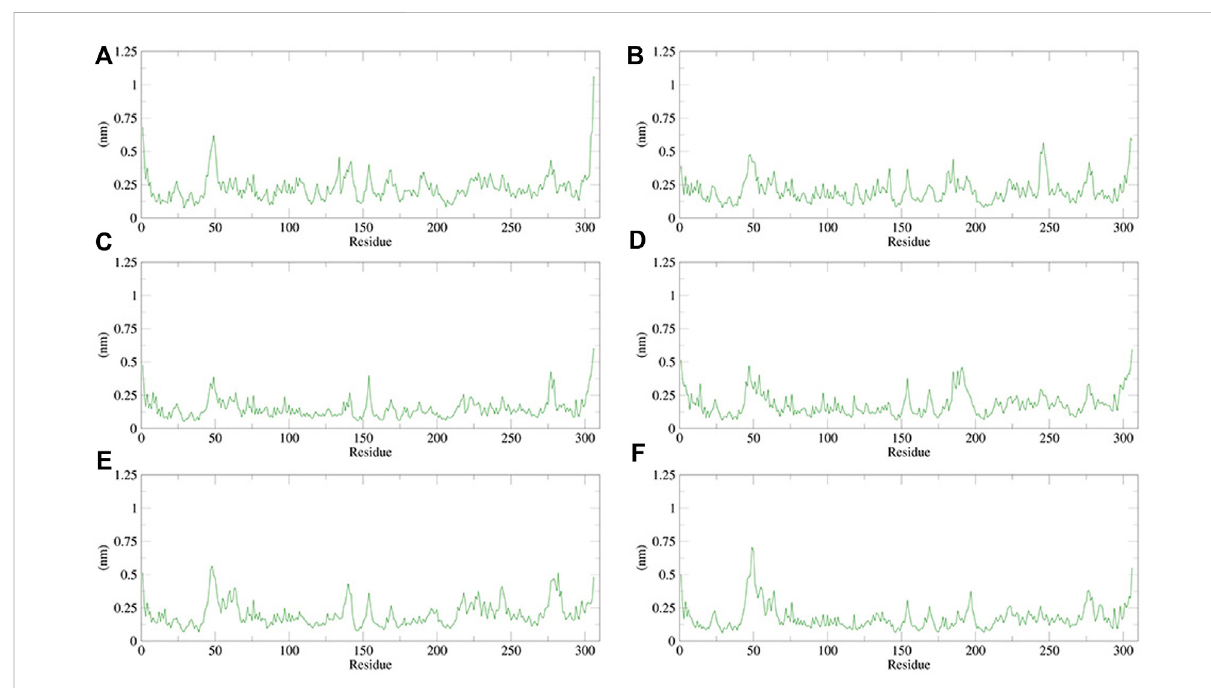
FIGURE 13 Plotofrootmeansquare fl uctuations(RMSF)values,during100nsMDsimulationofcompound – M pro complexes. (A) N3 – M pro RMSF; (B) N-1H- indazol-5-yl-2-(6-methylpyridin-2-yl)quinazolin-4-amine – M pro RMSF; (C) phthalocyanine – M pro RMSF; (D) antrafenine – M pro RMSF; (E) ergotamine – M pro RMSF; and (F) dihydroergotamine – M pro